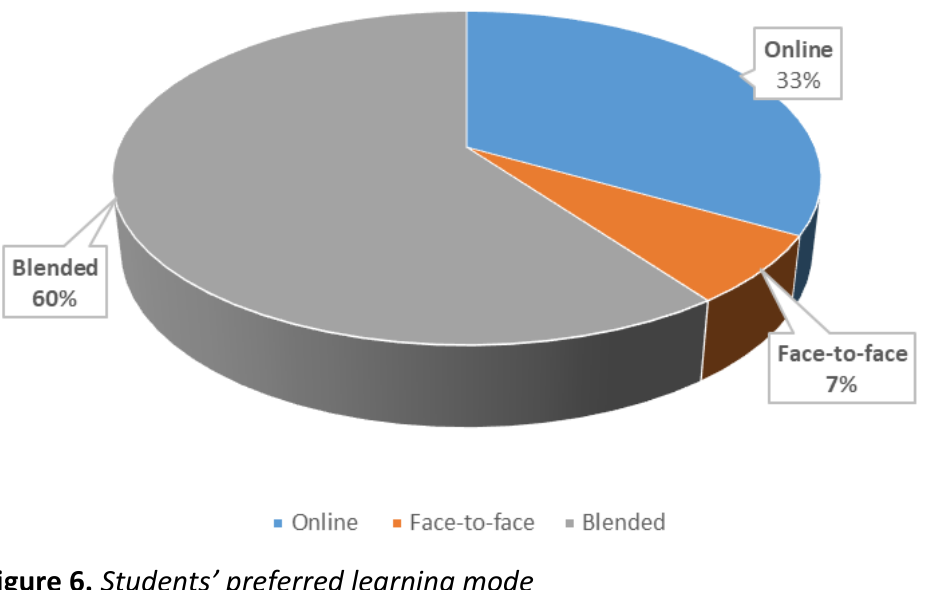
Figure 6. Students’ preferred learning